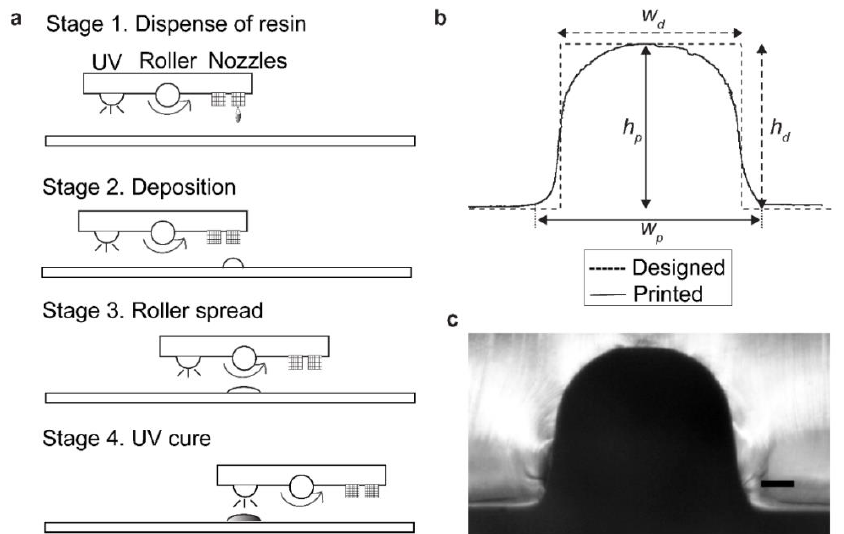
Figure 1. ( a ) Schematic illustration of the process of Polyjet printing. ( b ) Illustration showing the cross-sectional view of printed and designed structures. ( c ) Corresponding microscopic image obtained for the microscale structure with w d = h d = 500 µm. Scale bar = 100 µm.